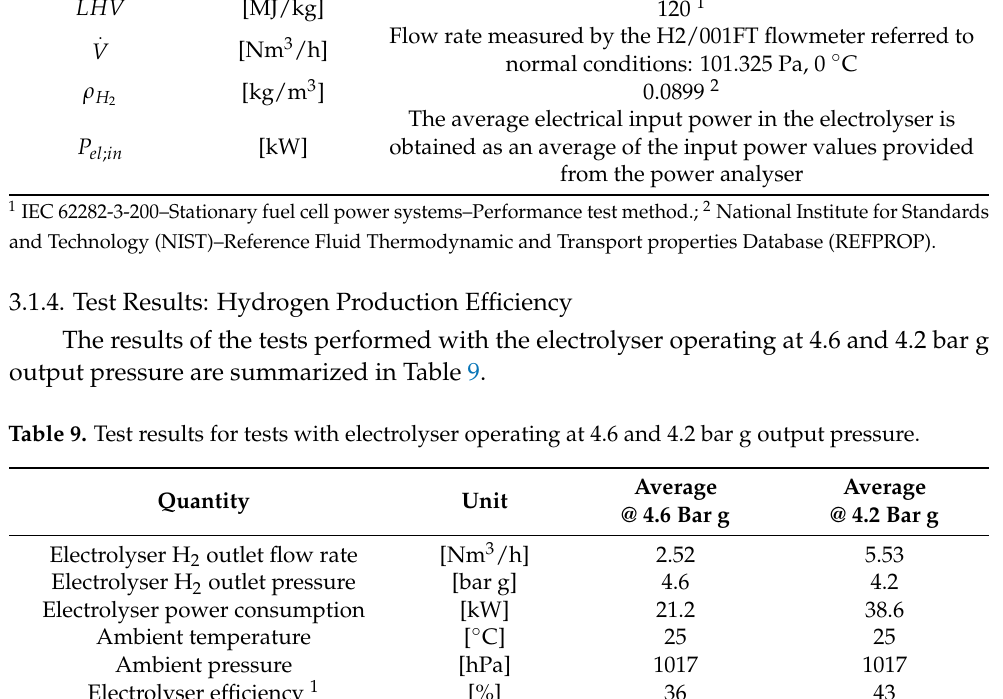
Table 8. Quantities used for the calculation of the electrolyser production efficiency, unit of measure- ment and methodology used for the calculation. Quantity Unit Formula, Calculation Method or Value P H [kW] Equation (4) 2 LHV [MJ/kg] 120 1 . Flow rate measured by the H2/001FT flowmeter referred to V [Nm 3 /h] normal conditions: 101.325 Pa, 0 ◦ C ρ H [kg/m 3 ] 0.0899 2 2 The average electrical input power in the electrolyser is P el ; in [kW] obtained as an average of the input power values provided from the power analyser